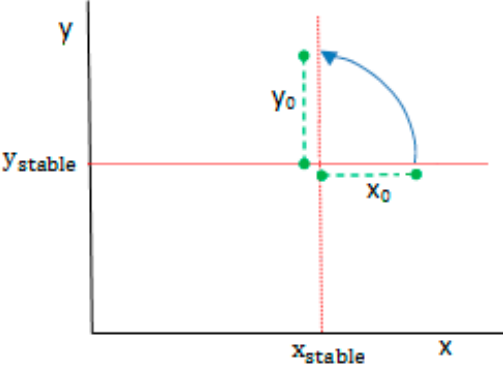
Figure 2. Starting and ending position of the path of the first quadrant according to the direction of rotation of the system.